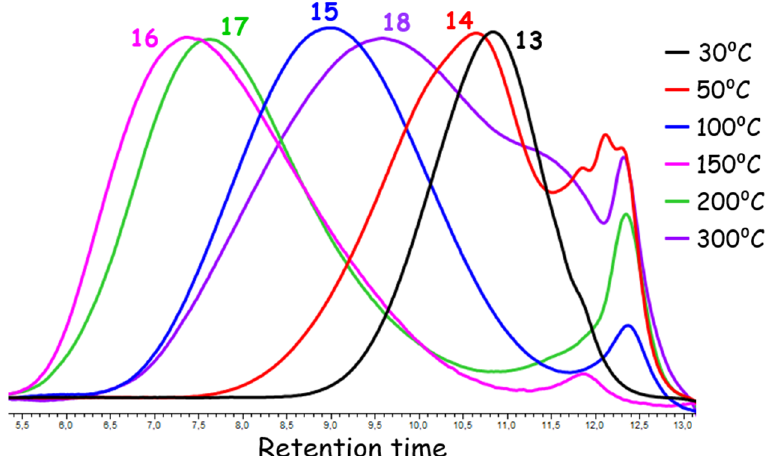
Figure 6. GPC curves obtained in Experiments 13 – 18 .